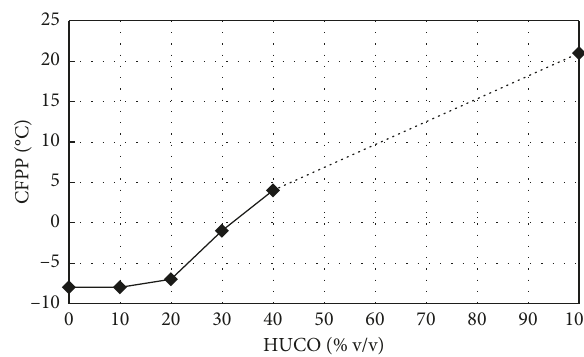
Figure 7: CFPP values of ULSD, HUCO, and their blends, mea- sured by EN 116 standard test method.